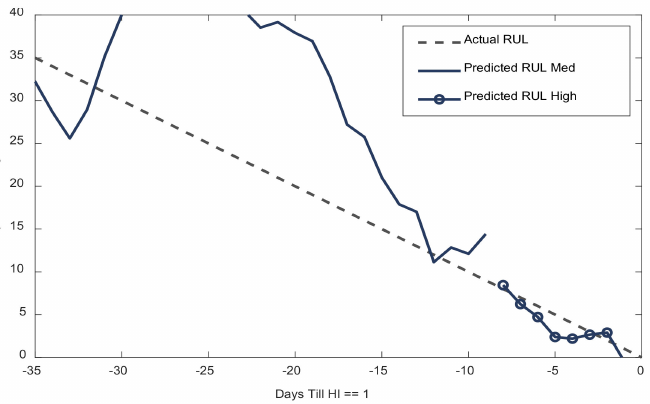
Figure 13. Bearing degradation RUL prediction results. Reproduced from [15], Elsevier.